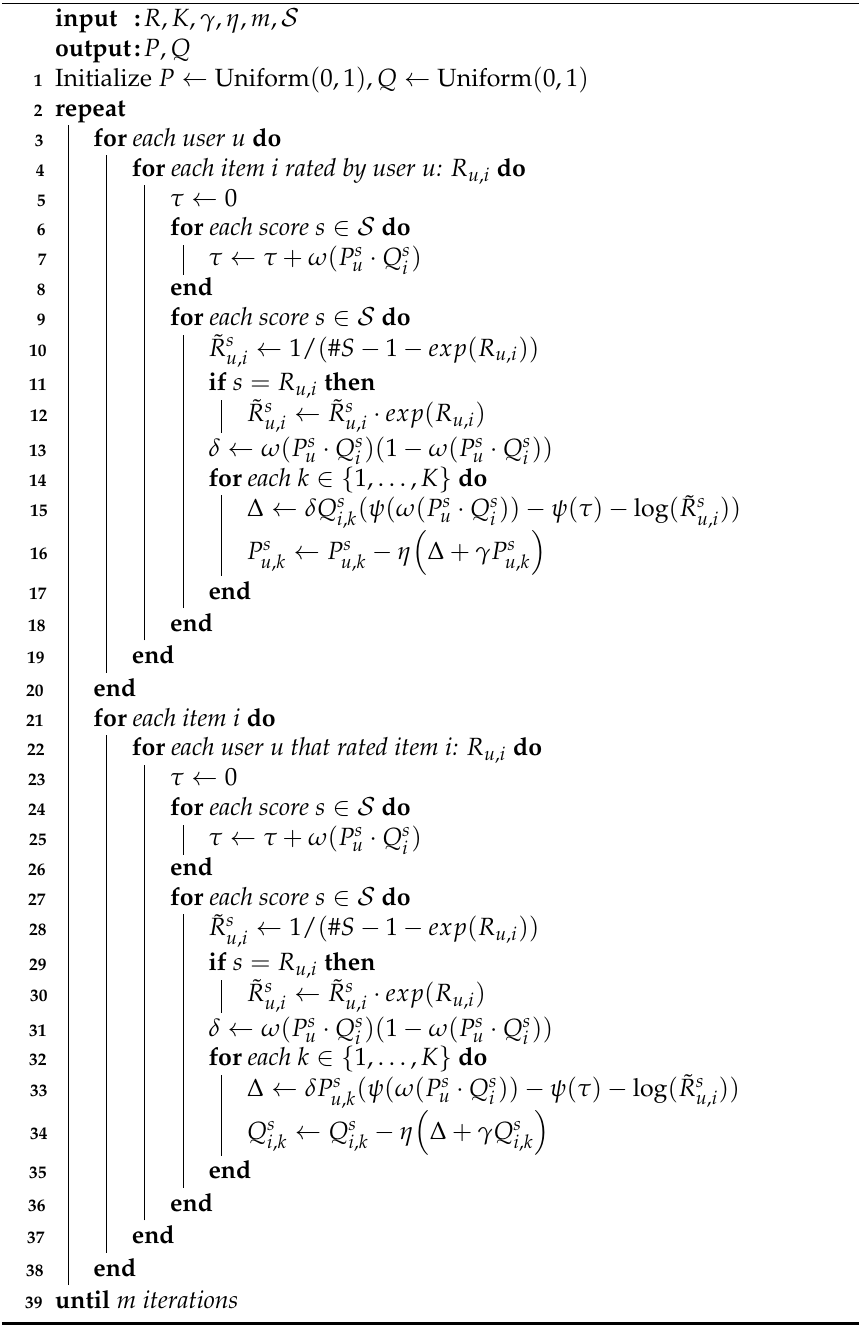
Algorithm 1: DirMF model fitting algorithm fixing ω for the logistic function and shape parameters β u , i = R u , i